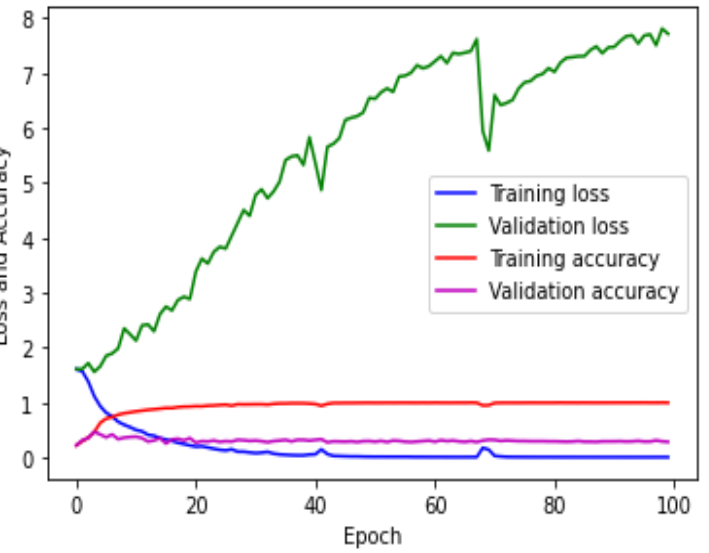
Figure 15. Error and accuracy measurements on training/validation sets for phase-only image da- taset.